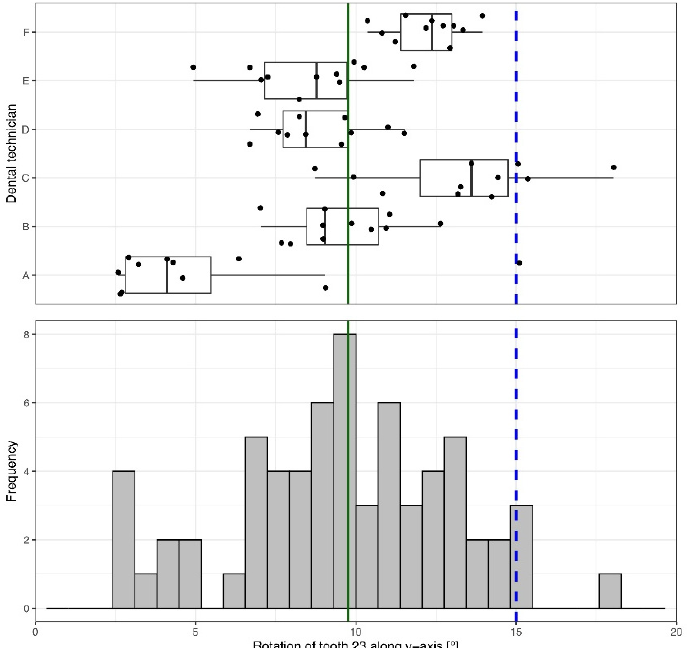
Figure 5. Rotation of tooth 23 around the y -axis (apical-occlusal). A rotation of 15 ◦ in the mesial direction was specified (blue dashed line); the median achieved across all technicians was 9.76 ◦ (green solid line). The box-and-whisker plot in the upper panel shows the measured movements of each individual dental technician. The histogram in the lower panel depicts the overall distribution of the measurements.